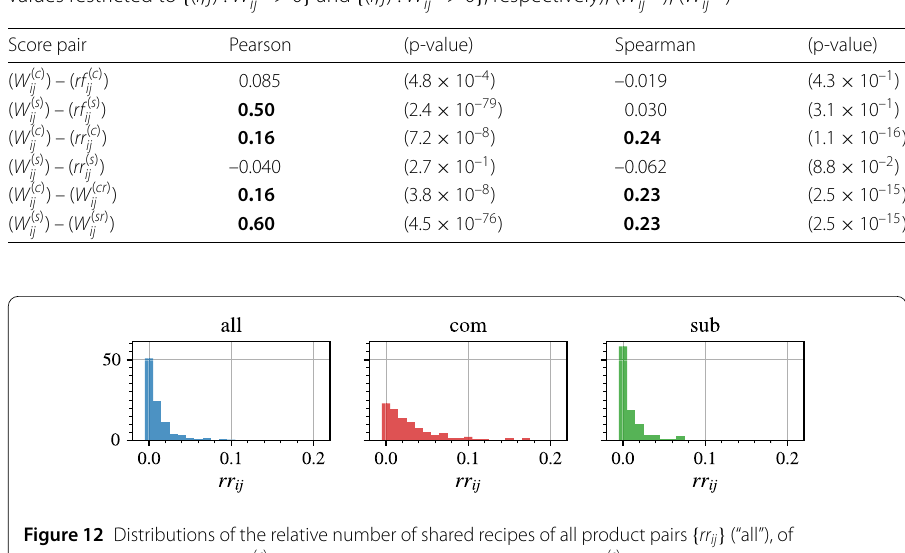
> 0 } (“sub”), where the range ij